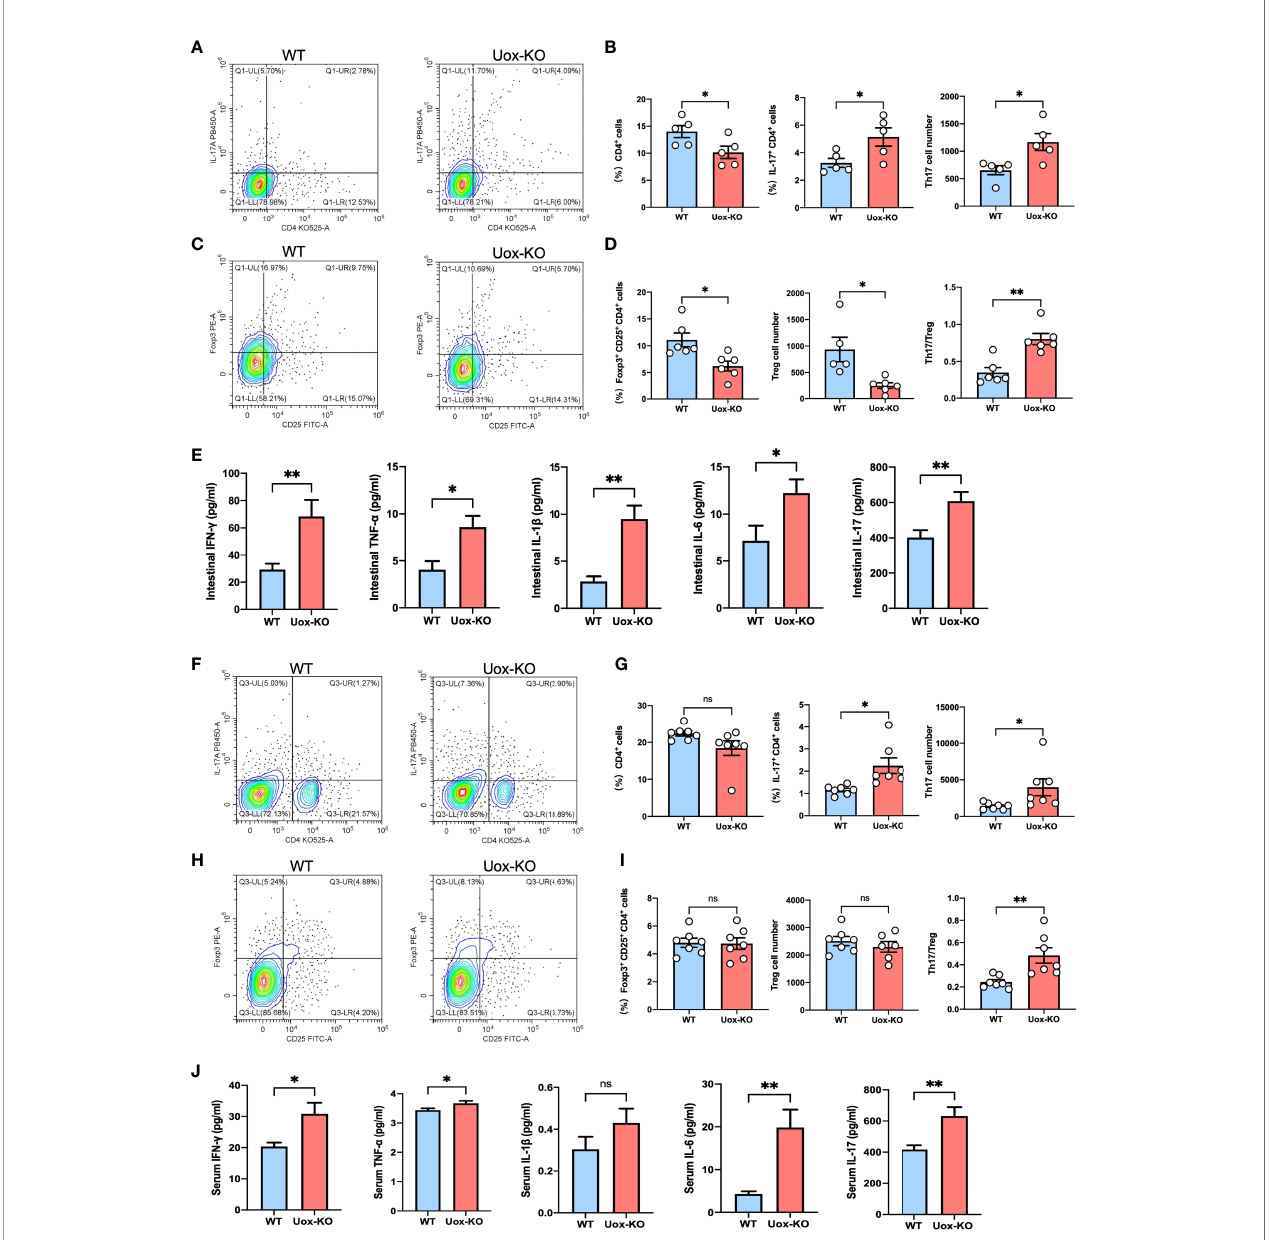
FIGURE 4 | Disruption of intestinal CD4 + T-cell homeostasis in Uox -KO mice. (A) Representative fl ow cytometry plots of the intestinal Th17 populations, which were measured as IL-17a + CD4 + CD45 + live cell percentages. (B) Percentage of intestinal CD4 + T cells, percentage and absolute number of intestinal Th17 cells, showing decreased population of CD4 + T cells and increased differentiation of Th17 cells in Uox -KO mice. (C) Representative fl ow cytometry plots of the intestinal Treg populations, which were measured as Foxp3 + CD25 + CD4 + CD45 + live cell populations. (D) Percentage and absolute number of intestinal Treg cells and the ratio of Th17/Treg cells, showing decreased Treg cells and increased Th17/Treg ration in Uox -KO mice. (E) The levels of intestinal IFN- g , TNF- a , IL-1 b , IL-6 and IL-17 were measured by ELISA. (F) Representative fl ow cytometry plots of the spleen Th17 populations. (G) Percentage of spleen CD4 + T cells, percentage and absolute number of Th17 cells. (H) Representative fl ow cytometry plots of the spleen Treg populations. (I) Percentage and absolute number of spleen Treg cells and the ratio of Th17/Treg cells in spleen. (J) The levels of serum IFN- g , TNF- a , IL-1 b , IL-6 and IL-17. Values are expressed as mean ± SEM. “ ns ” represents not signi fi cant; * p < 0.05; ** p <